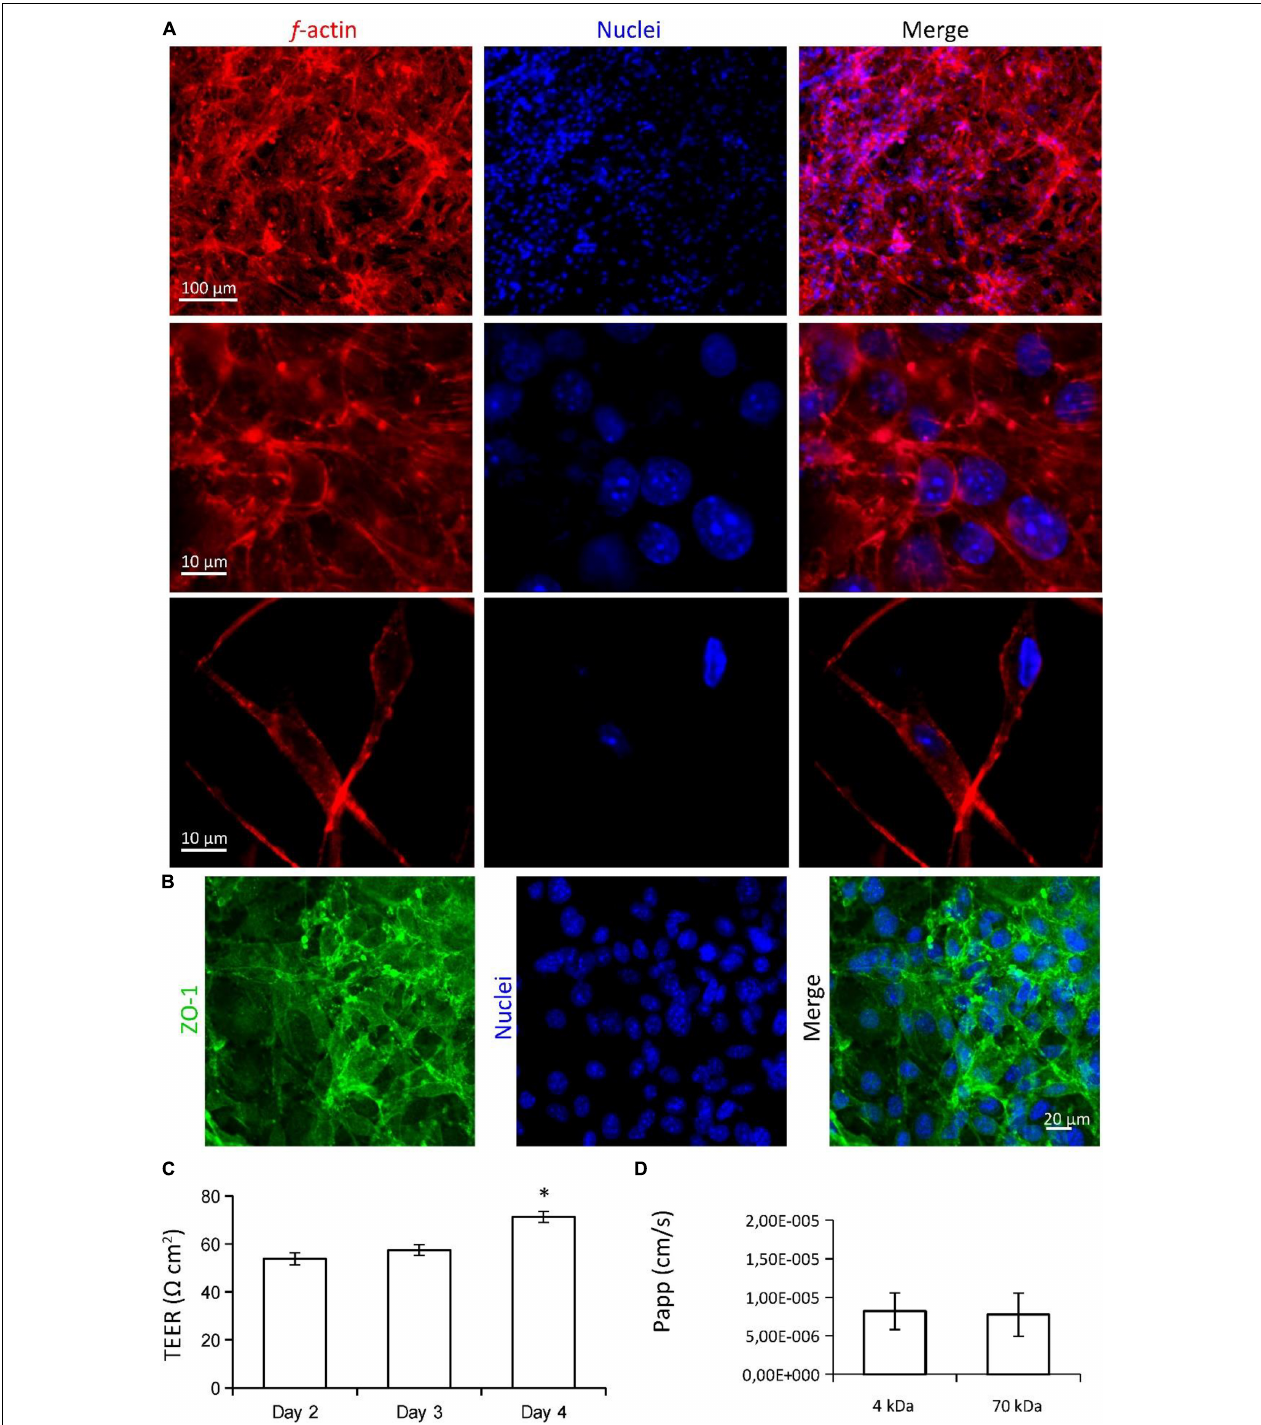
FIGURE 5 | Imaging and characterization of the in vitro BBB model on CA electrospun scaffolds (25 min spinning time). (A) Confocal laser scanning microscopy (CLSM) imaging of the endothelial cells ( f -actin in red, nuclei in blue) on the CA electrospun scaffolds. Low magnification (top) and high magnification (middle) imaging show as endothelial cells develop a biological barrier on the surface of the CA scaffold; CLSM imaging of the CA substrate (bottom) shows as few cells were able to migrate inside the scaffold. (B) Immunofluorescence staining and CLSM imaging of ZO-1 tight junction marker (in green), and nuclei (in blue). (C) TEER measured at different time points (2, 3, and 4 days from seeding). (D) Apparent permeability ( Papp ) of the BBB model. * p < 0.05.